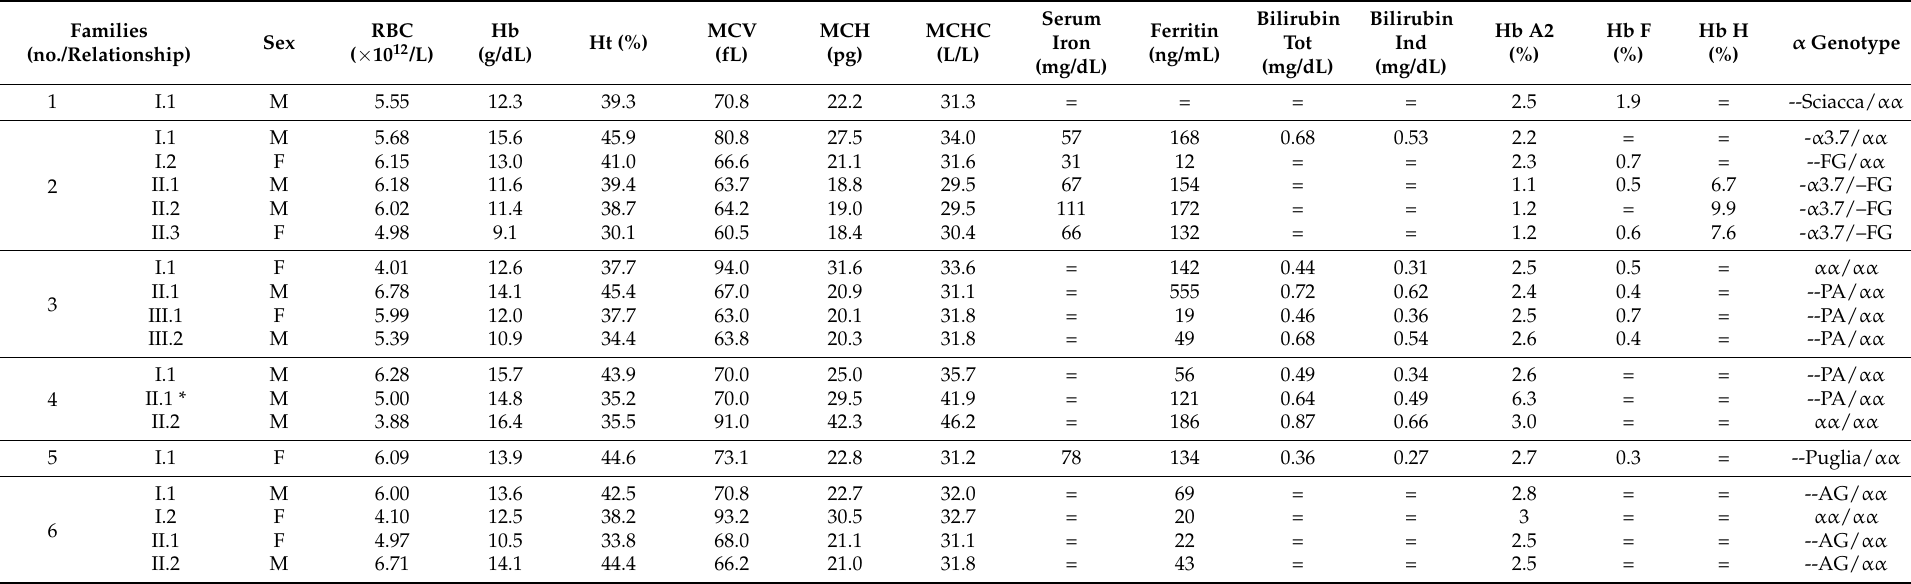
Table 1. Hematologic, biochemical data, and α -genotype of the families with the new α -thalassemia